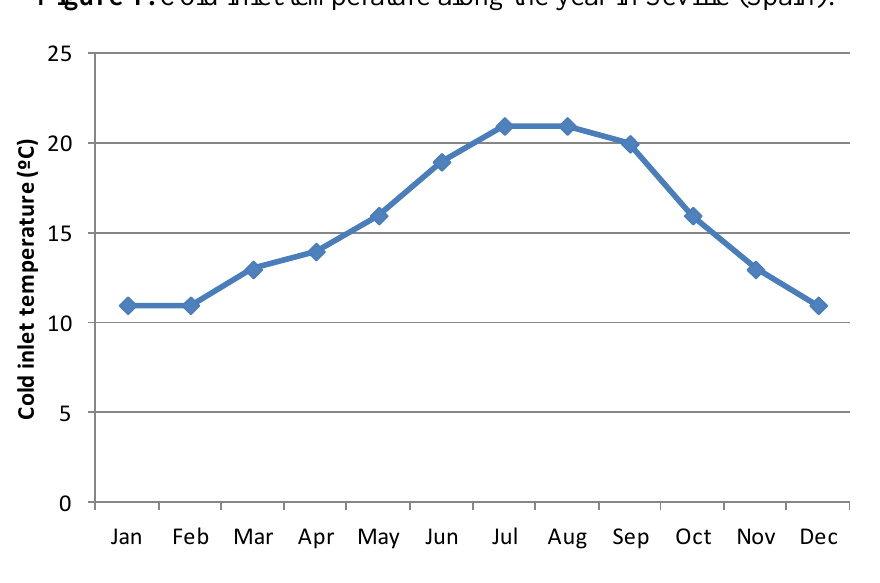
Figure 1. Cold inlet temperature along the year in Seville